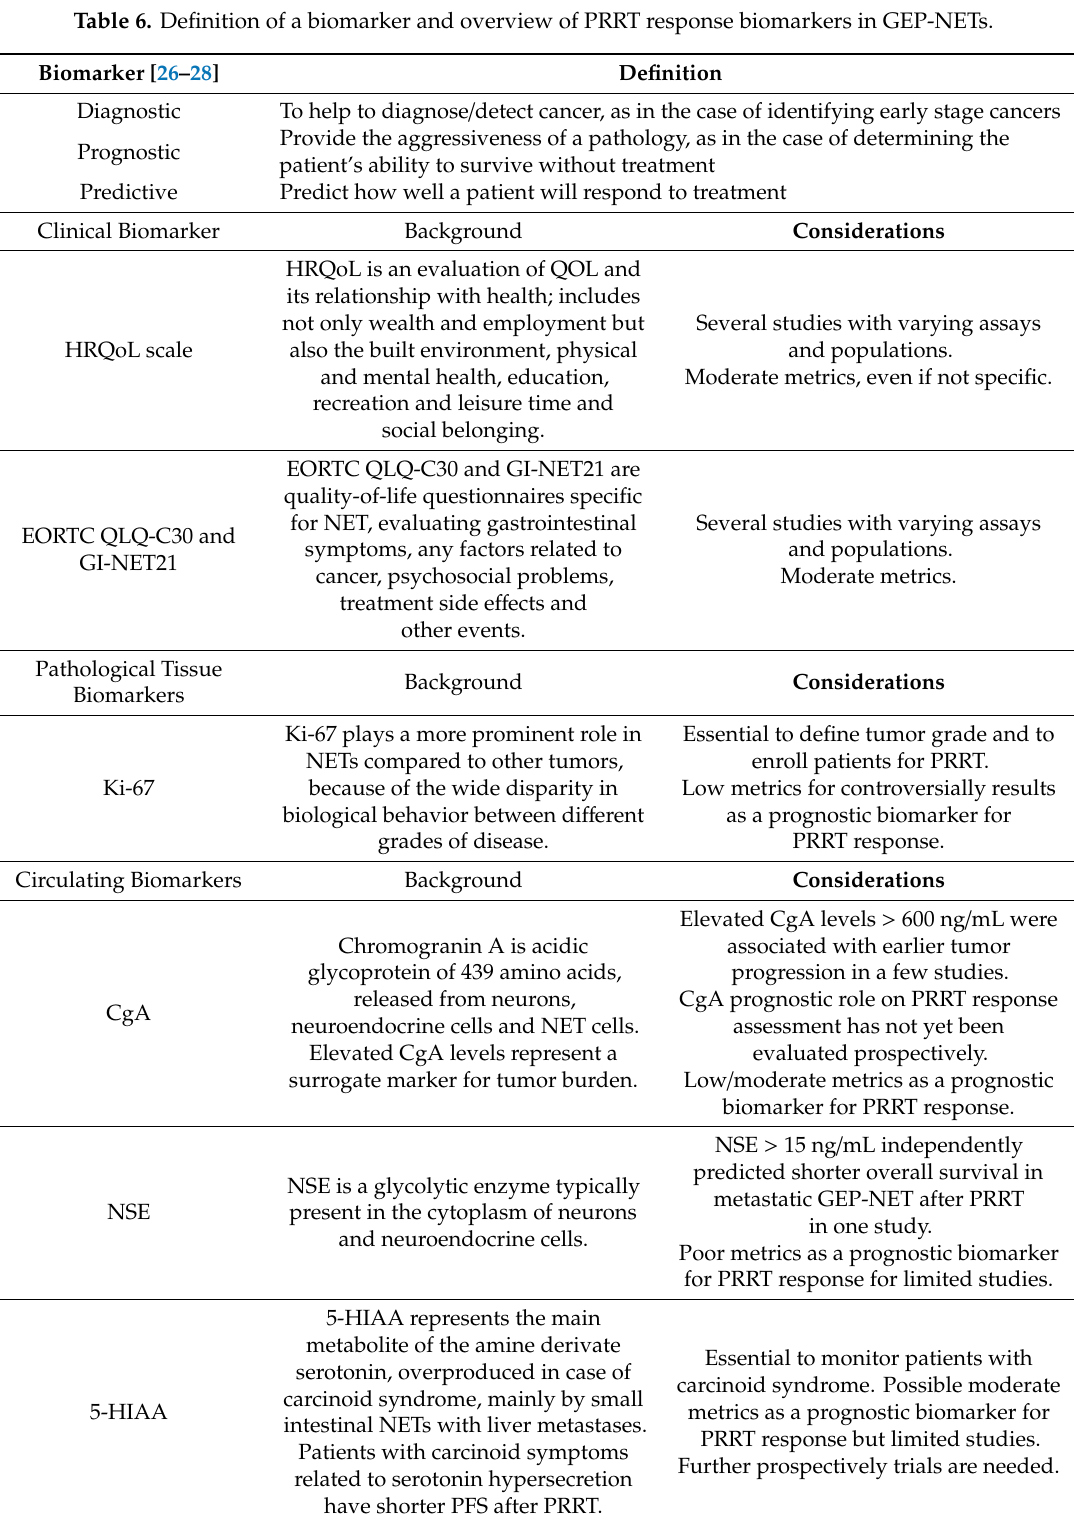
Table 6. Definition of a biomarker and overview of PRRT response biomarkers in